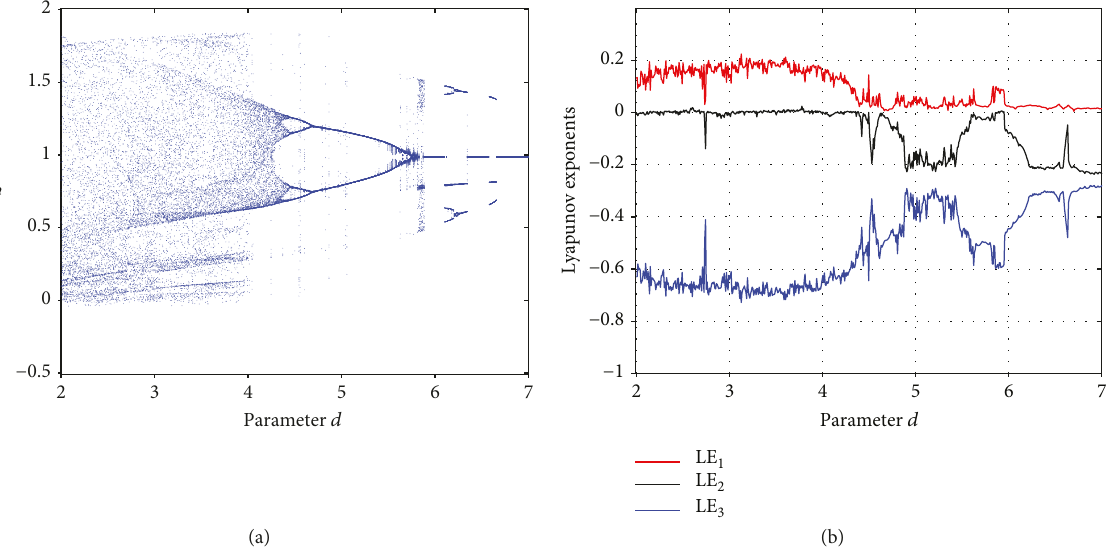
Figure 5: (a) Bifurcation diagram and (b) Lyapunov exponent spectrum versus parameter d